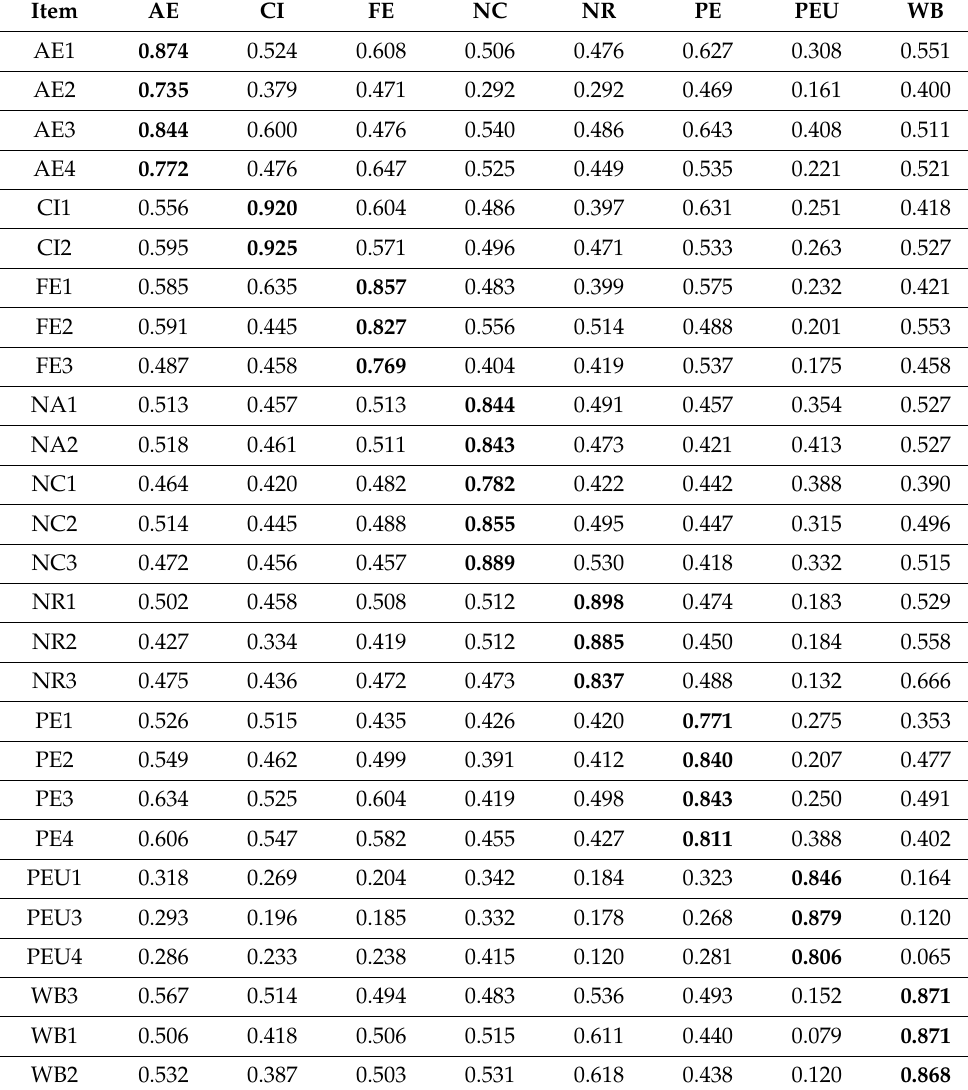
Table 4. Loading and cross-loading